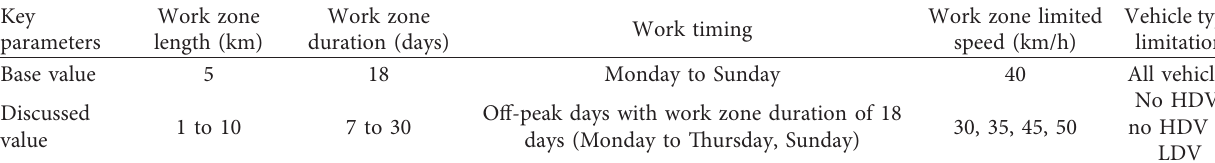
Table 4: Base value and discussed value of key parameters in work zone user CO Key